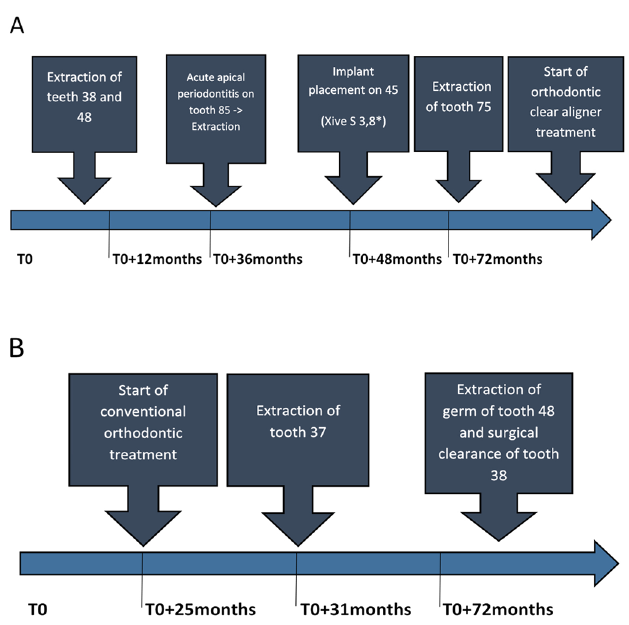
Fig. 1. Timeline and follow-up of patients A and